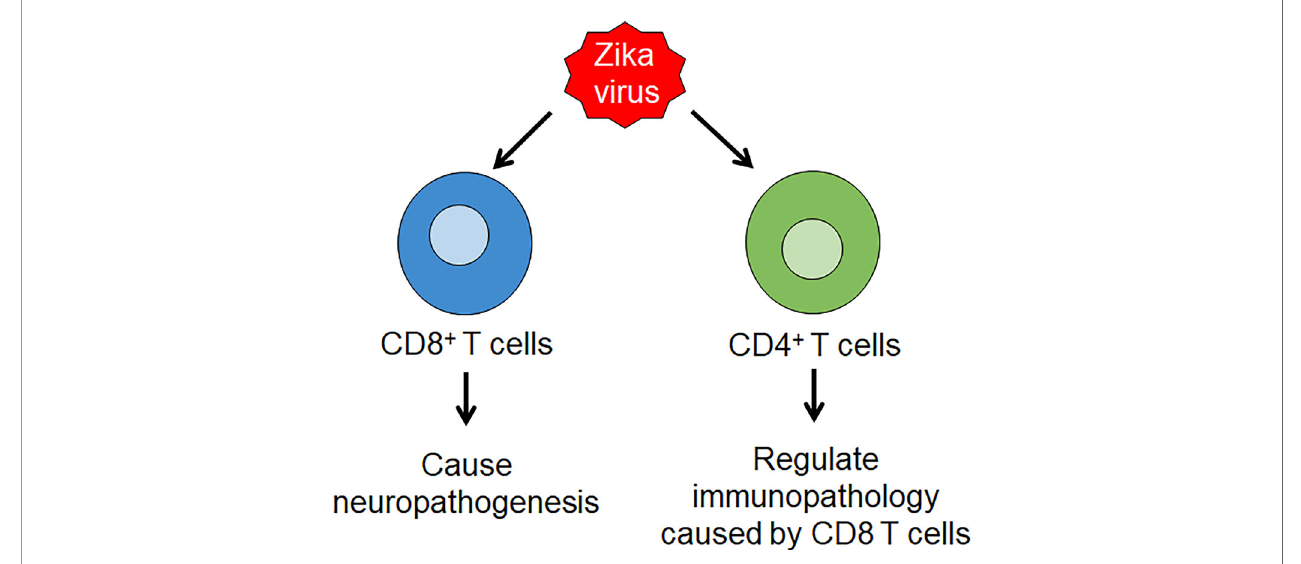
FIGURE 2 | Zika virus (ZIKV) infection induces T cell immunity. ZIKV infection leads to the production of Th 1 CD4 T cell and effector CD8 T cell responses. CD8 T cells lead to ZIKV neuropathology, while CD4 T cells play a regulatory role through reduction of immunopathology caused by CD8 T